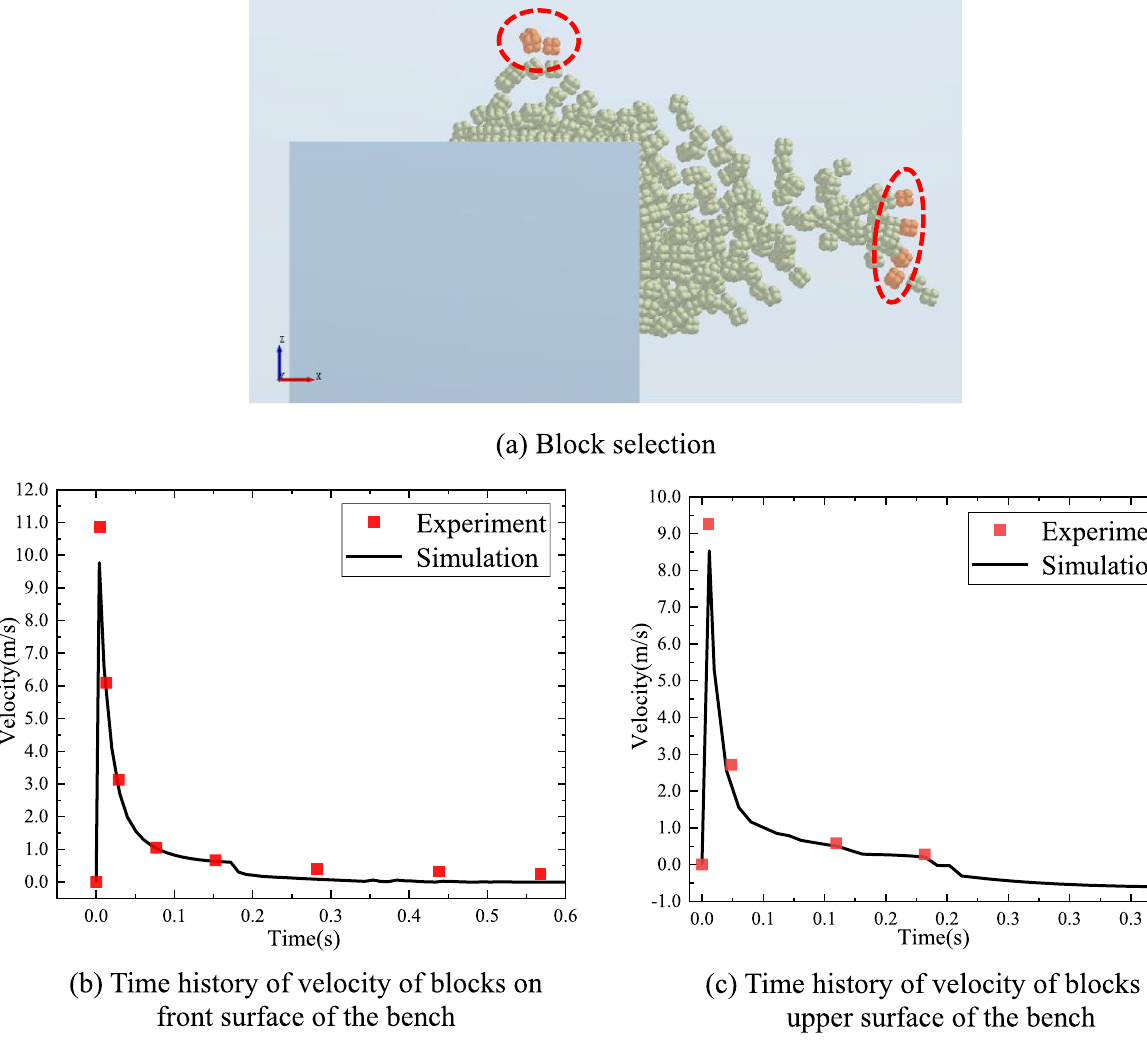
Figure 16. Comparison between the simulated and experimental curves (0.8 g).